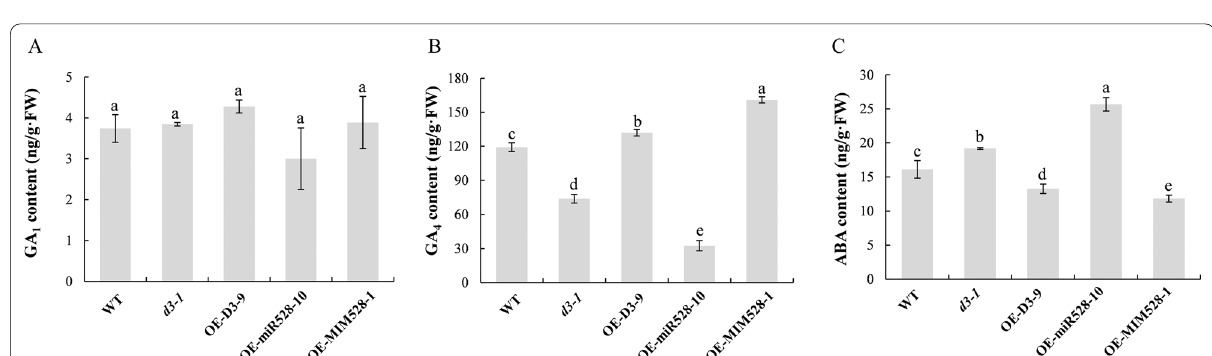
Fig. 4 Comparative analysis of endogenous GA 1 ( A ), GA 4 ( B ), and ABA content ( C ) in 31-day-old seedlings of WT and transgenic lines. Significant differences ( P < 0.05) are indicated by different